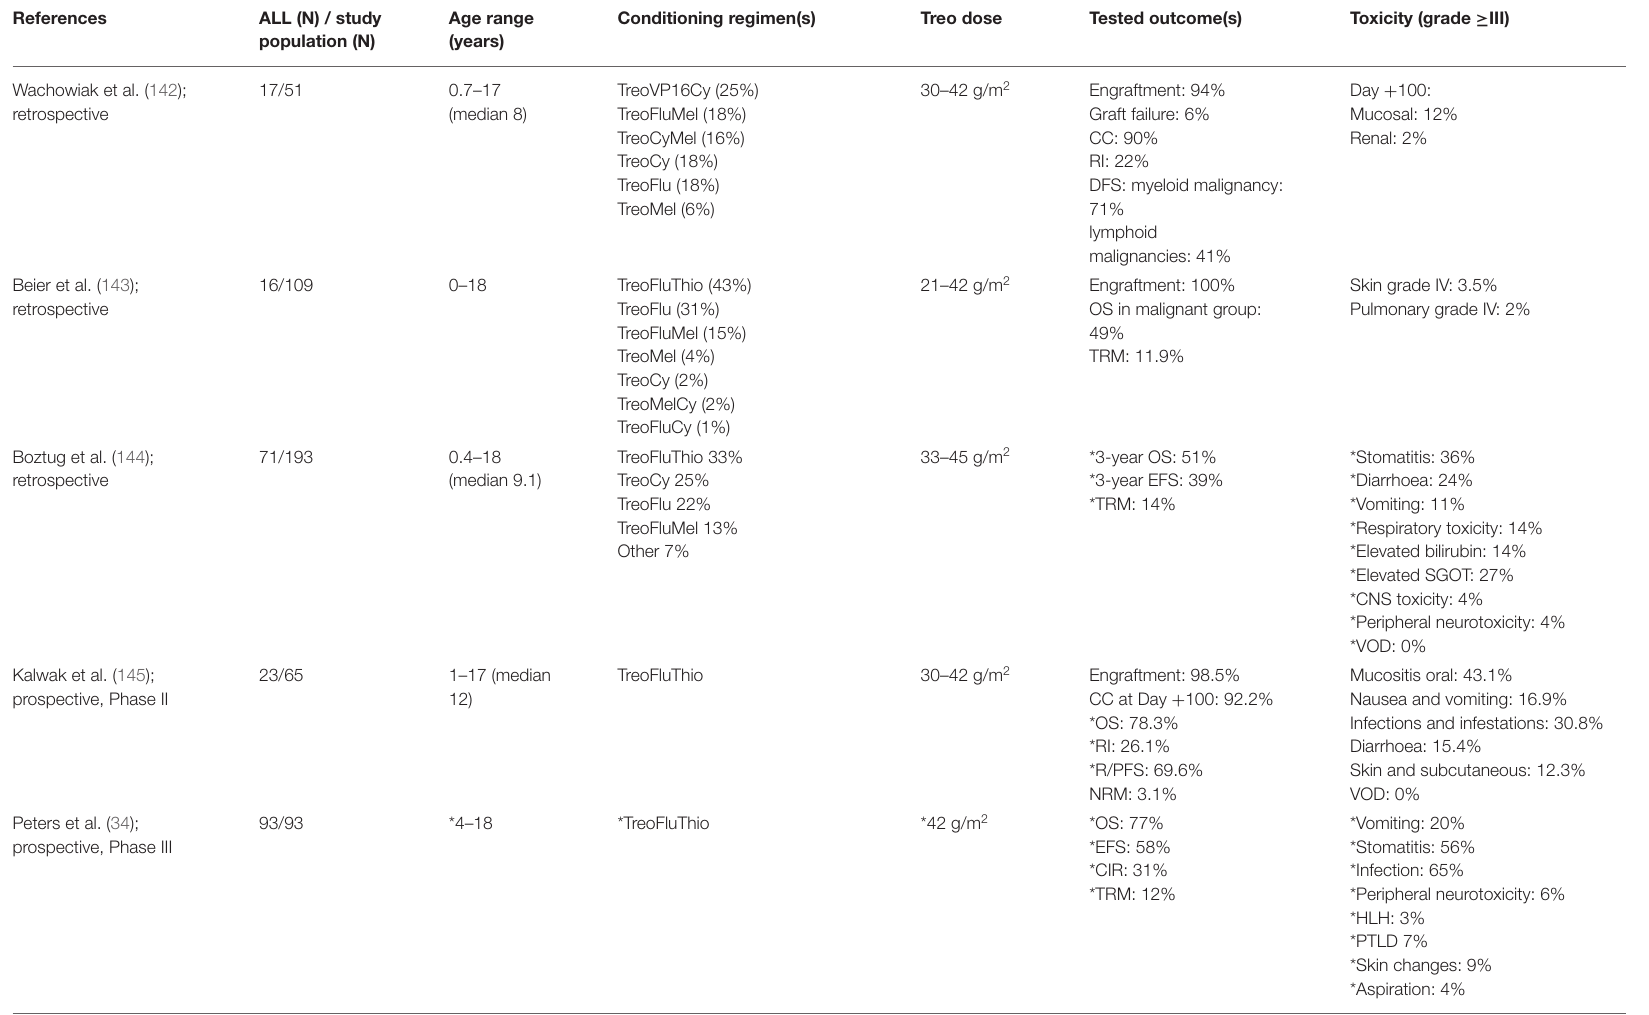
TABLE 4 | Summary of studies assessing the use of treosulfan conditioning in children with malignant